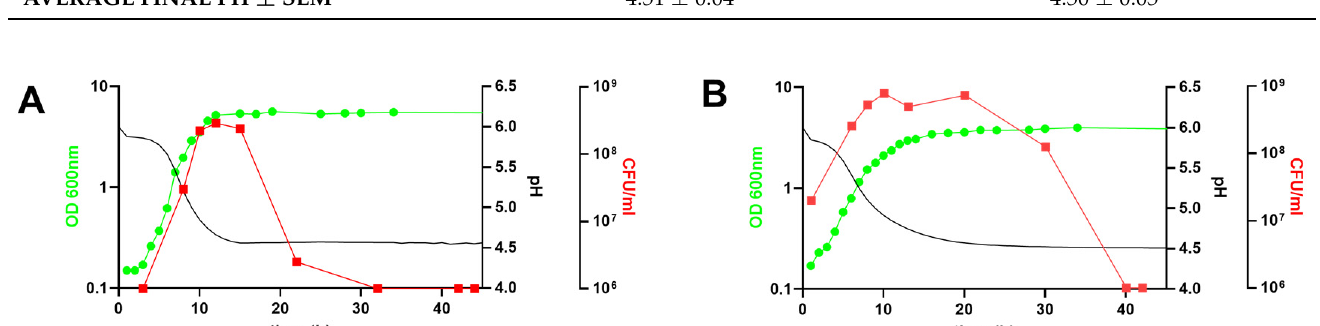
Figure 1. Growth characteristics of B. longum NCC 2705 grown in DasGip bioreactors with 1% of glucose ( A ) or 1% of galactose ( B ). Optical density measured at 600 nm (OD; green circles), cell concentration measured by Colony Forming Unit (CFUs, red squares) and pH (black line) are depicted for each condition.